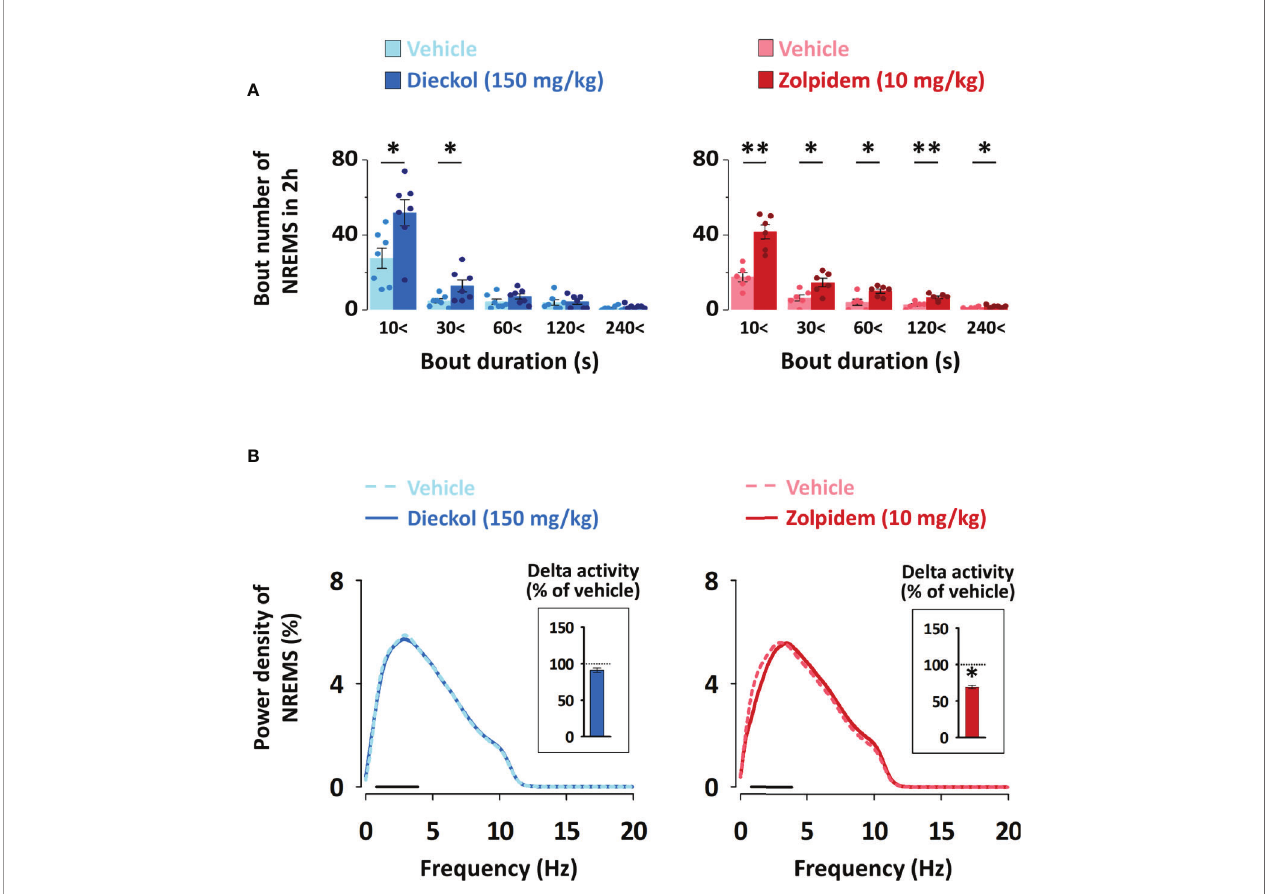
FIGURE 6 | (A) Changes in the number of NREMS and Wake bouts of different durations in C57BL/6N mice after oral administration of dieckol or zolpidem. Light and dark bars indicate the baseline day (vehicle administration) and experimental day (dieckol or zolpidem administration), respectively. Each column represents the mean ± SEM (n = 6 – 7) with data points. * p < 0.05 and ** p < 0.01, signi fi cant difference compared to the vehicle (paired Student ’ s t -test). (B) Electroencephalogram (EEG) power density curves of NREMS caused by dieckol and zolpidem. Delta activity, an index of sleep intensity, is shown in the inset histogram. The dash ( ▬ ) represents the range of the delta wave (0.5 ‒ 4 Hz). * p < 0.05, signi fi cant difference compared to the vehicle (two-way ANOVA with Bonferroni post-test). NREMS, non-rapid eye movement